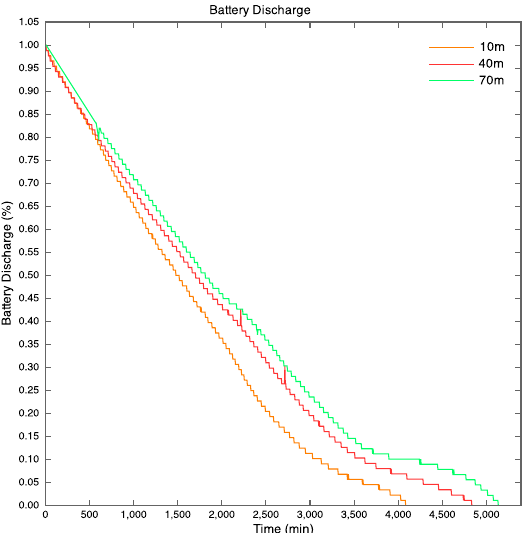
Figure 7. Battery discharge curves for Experiment